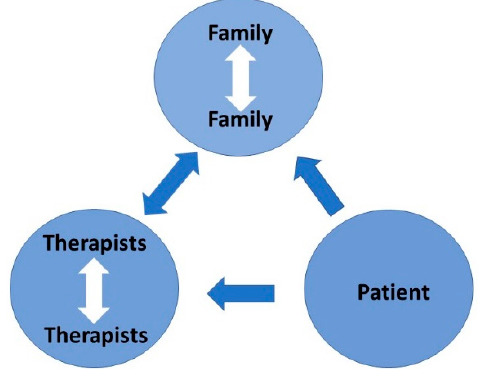
Figure 17. Therapeutic dynamic: the key is to